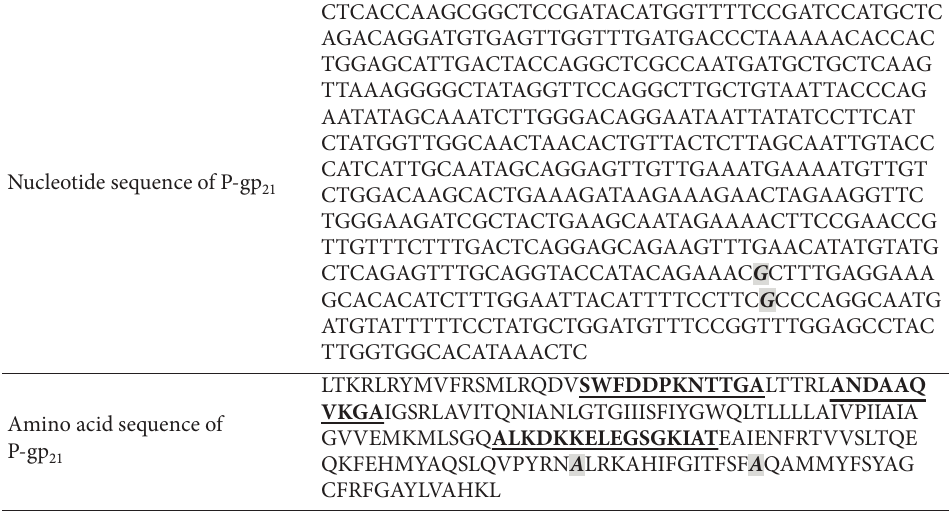
sequence with that retrieved from NCBI. 21